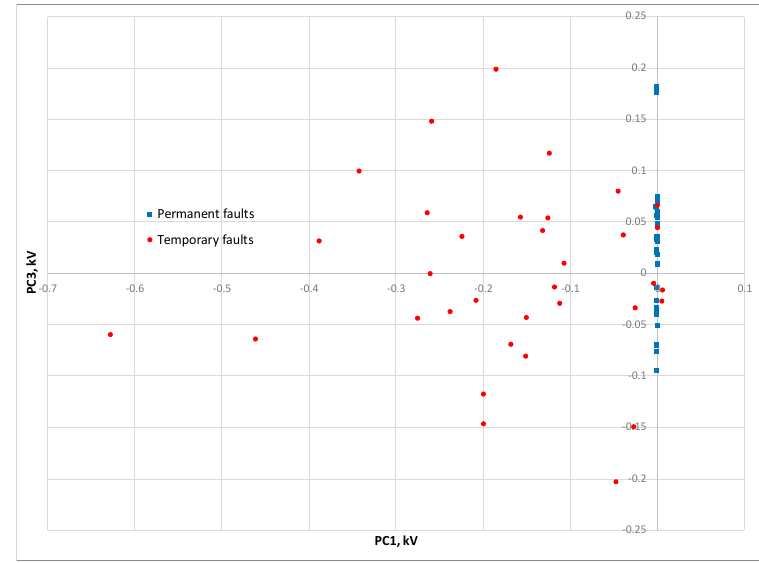
Figure 7. Permanent and temporary faults in the first and third subspace of